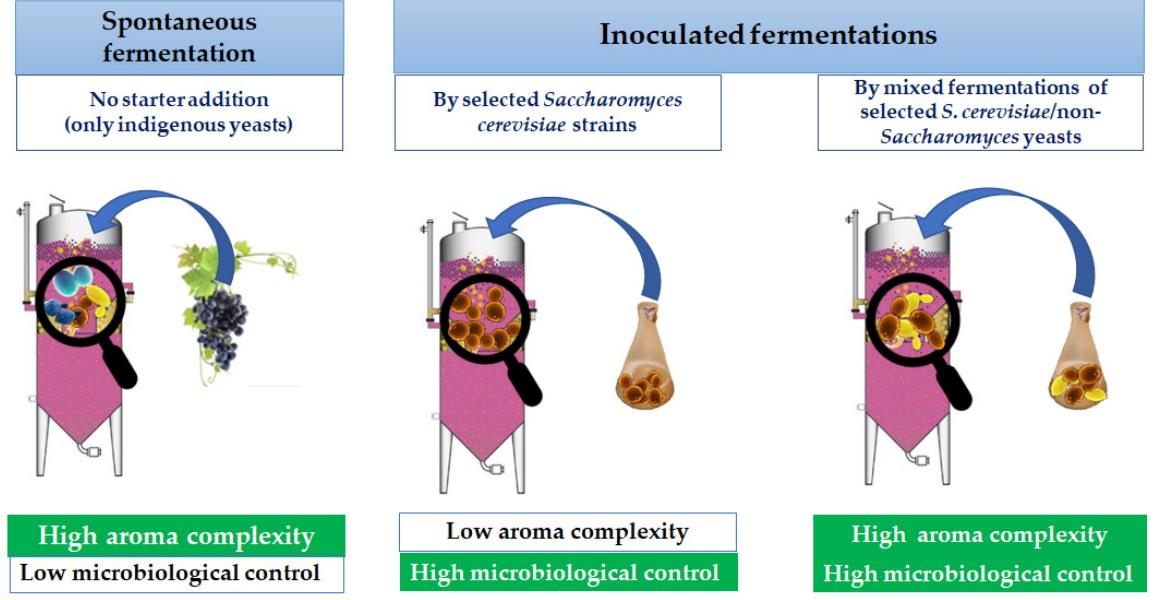
Figure 6. Effects of the presence of non- Saccharomyces and Saccharomyces yeasts on wine aroma pro- file.